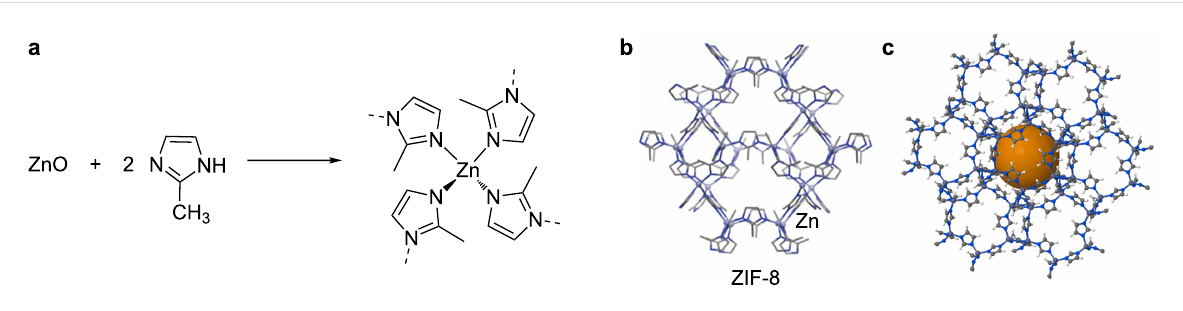
Figure 6: a) Synthesis of ZIF-8; b) fragment of the crystal structure of ZIF-8. Reprinted with permission from [145], copyright 2015 Macmillan Publishers Ltd. c) image generated for ZIF-8 in http://www.chemtube3d.com (University of Liverpool).